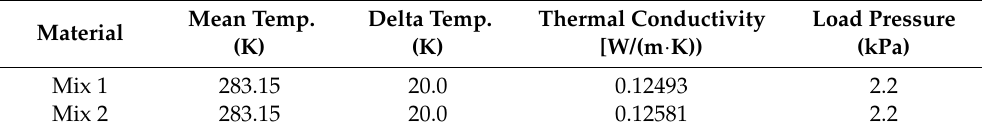
Table 8. Thermal conductivity of the manufactured